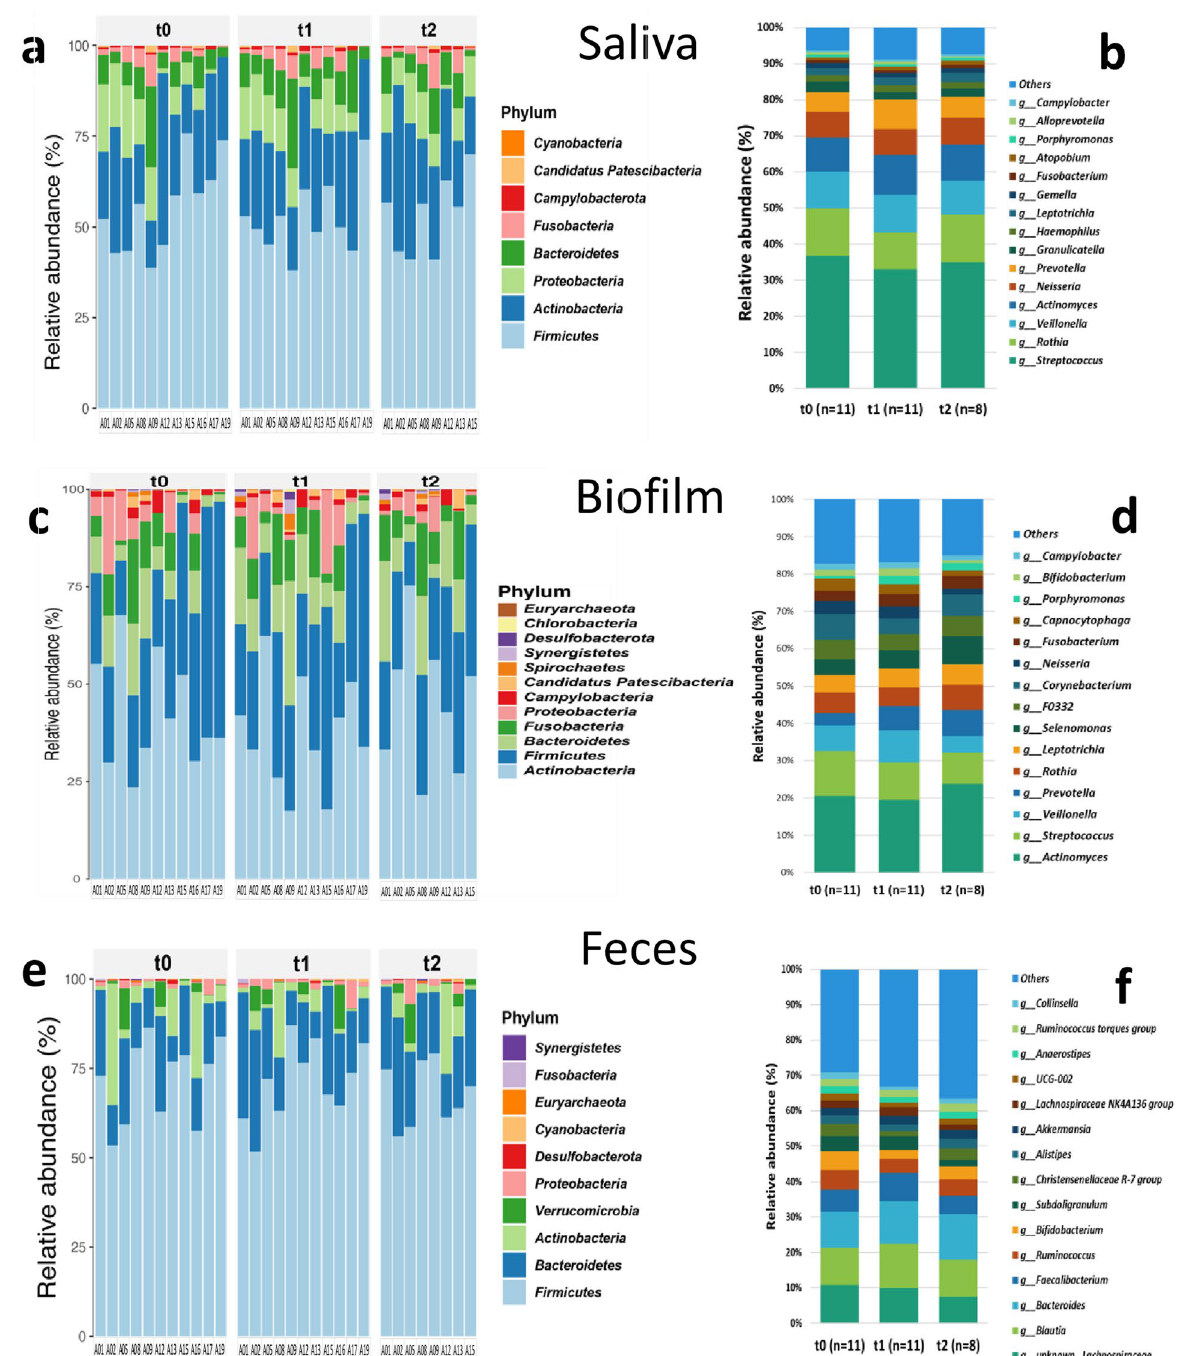
Figure 3. Changes in the oral ( a – b saliva and c – d teeth-attached biofilm) and intestinal ( e – f ) microbiome from baseline (t0) to one (t1) and four (t2) weeks of SFOH administration. Phylum composition is presented on the left ( a , c , e ) and genera composition on the right side ( b , d , f